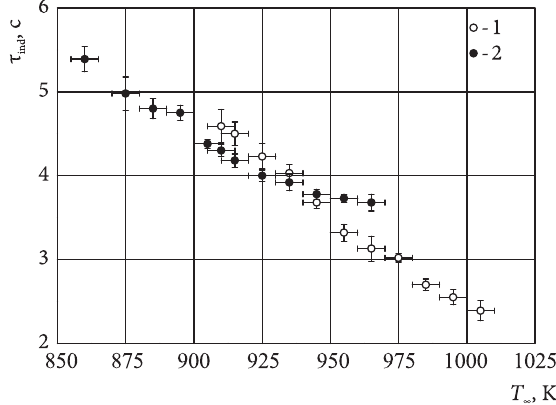
Fig. 3. Single droplet ignition delay time reliance on ambient temperature: 1 – diesel fuel (MD), 2 – RME. Initial droplet radius r = 1,125 0